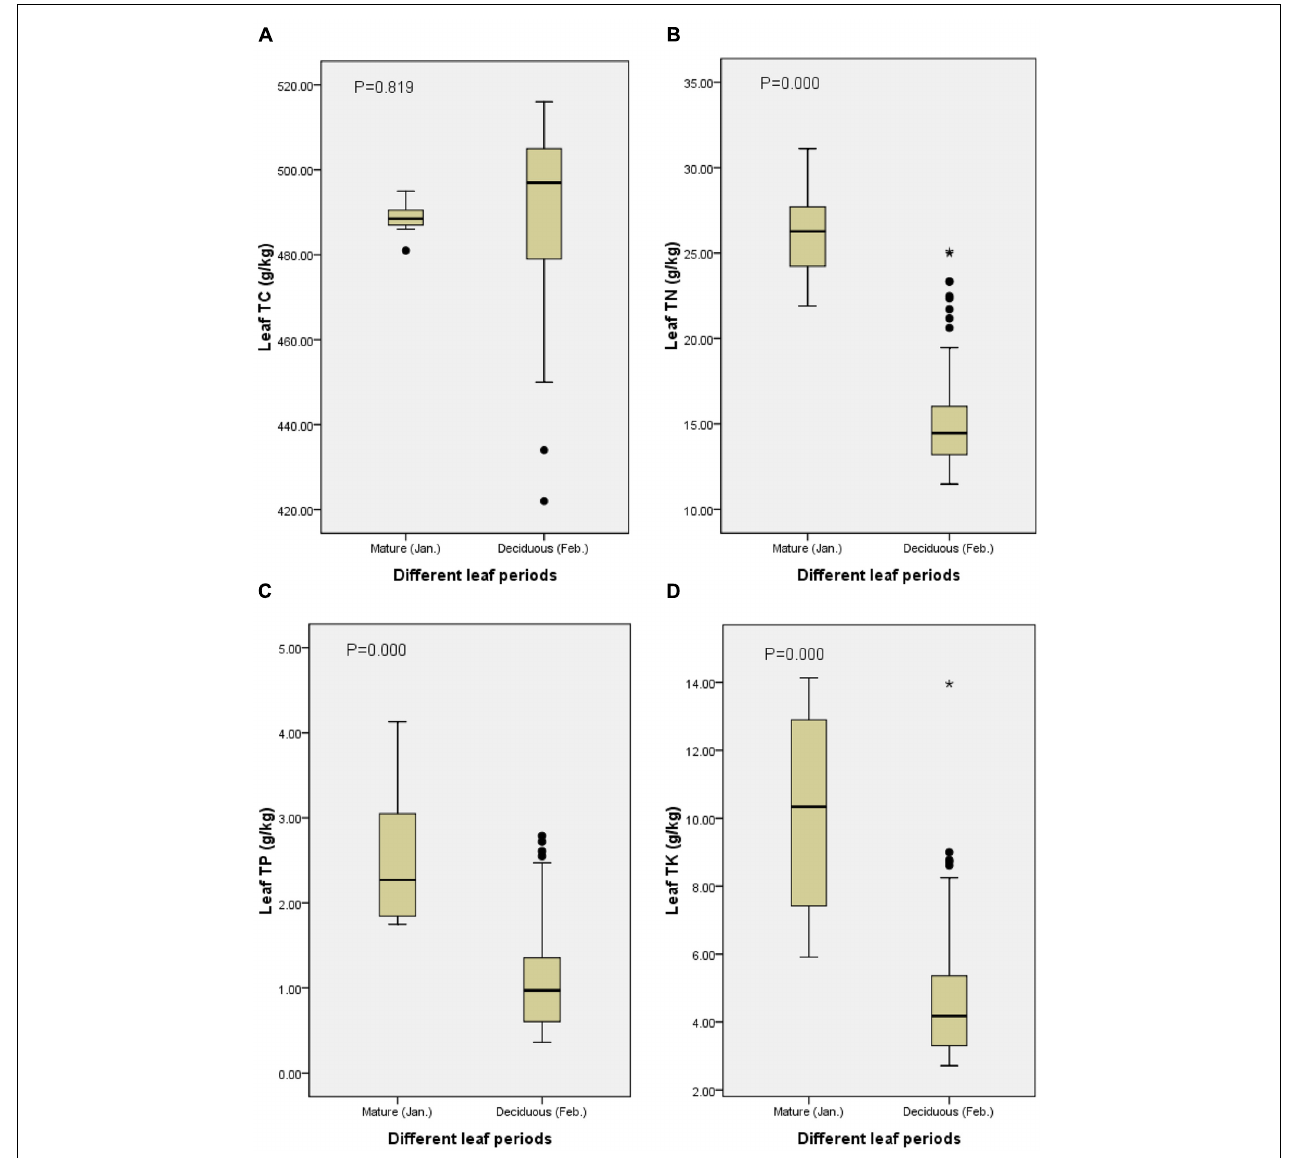
FIGURE 2 | Comparison of the average concentrations of (A) total carbon (TC), (B) total nitrogen (TN), (C) total phosphorus (TP), and (D) total potassium (TK) in live and senescent leaves.